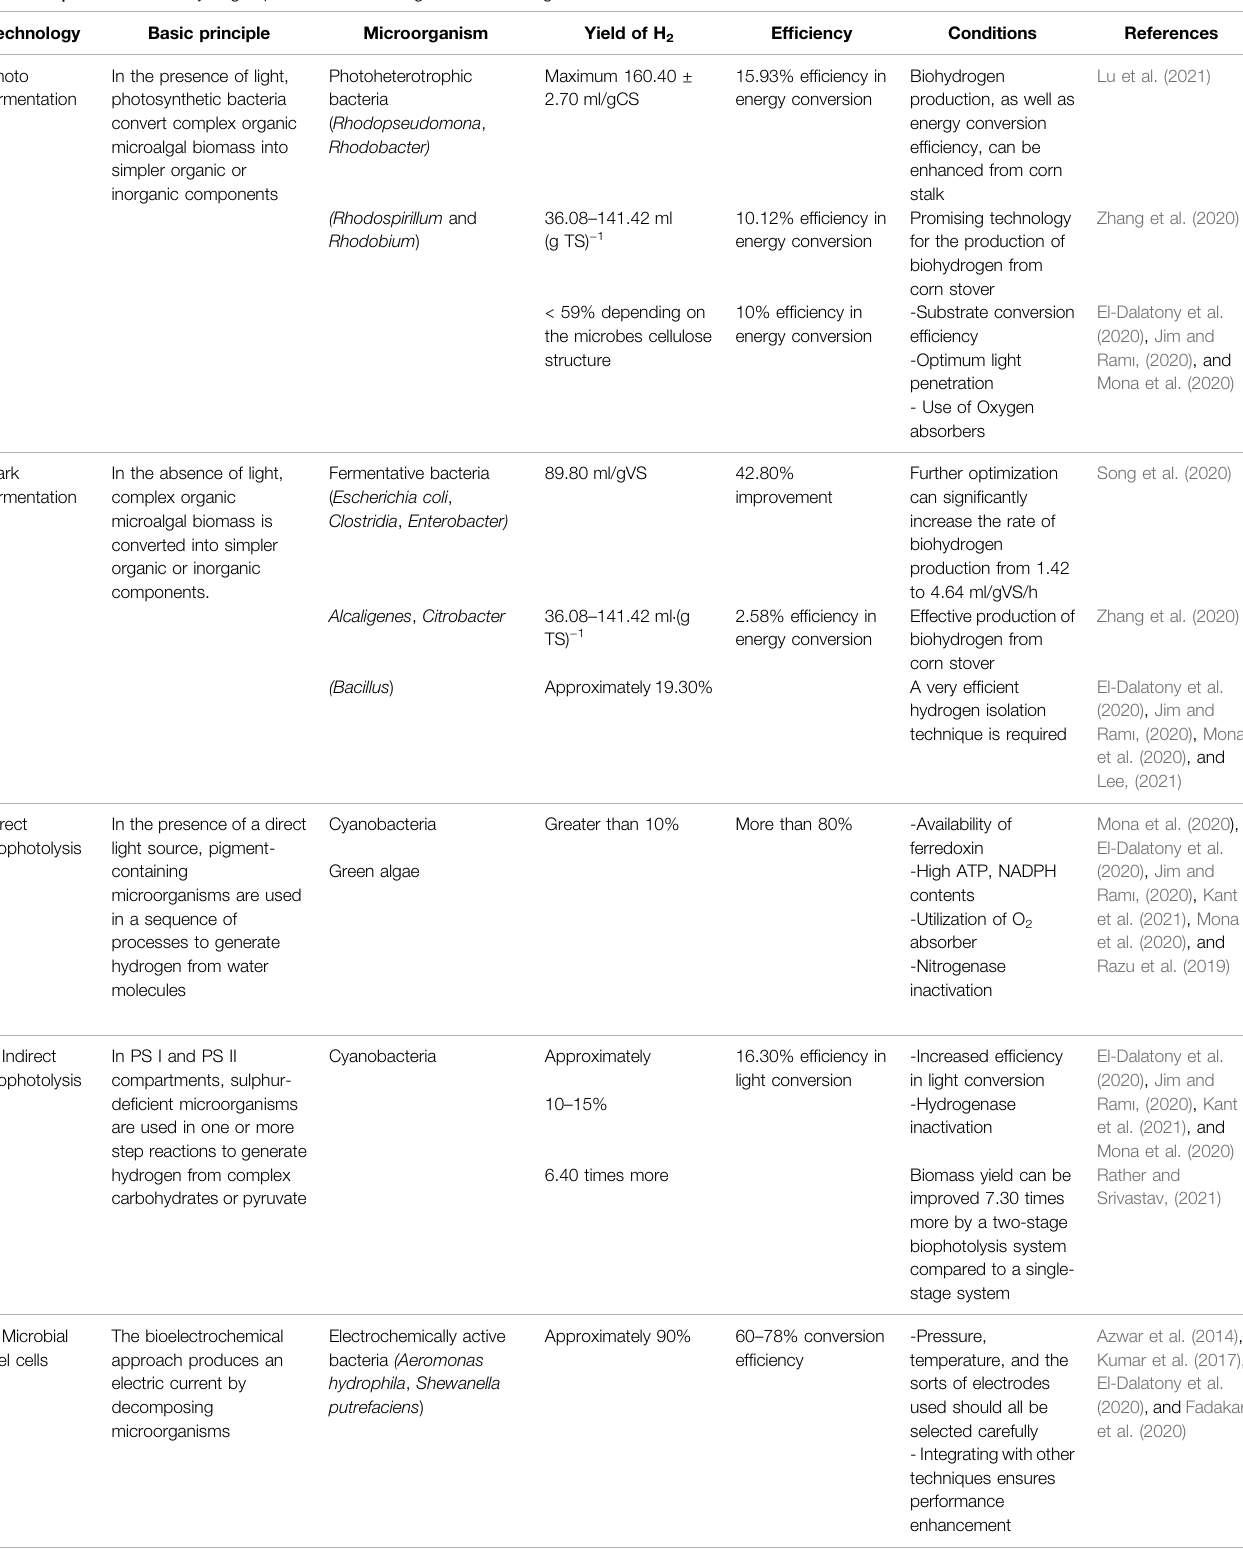
TABLE 3 | Overview of biohydrogen production technologies from